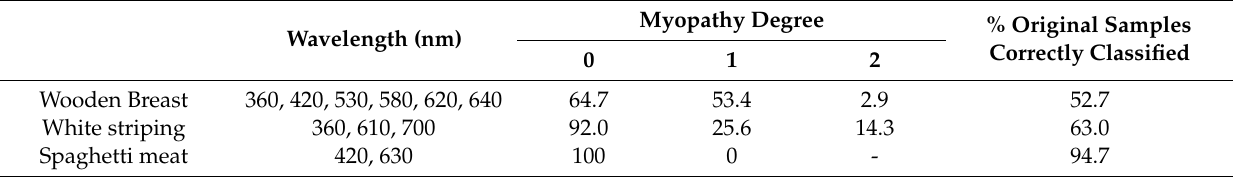
Table 3. Classification of breast myopathies (% of samples correctly classified) from visible spectrum (360–740